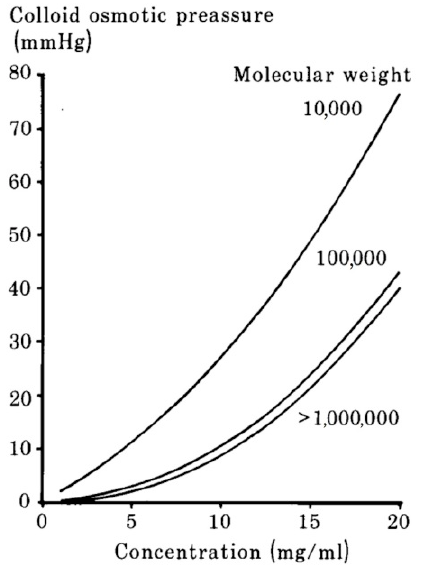
Figure 17. Dependence of the colloid osmotic pressure of hyaluronate solutions on concentration and molecular weight. Adapted from [50], with permission from Taylor & Francis, 2020.